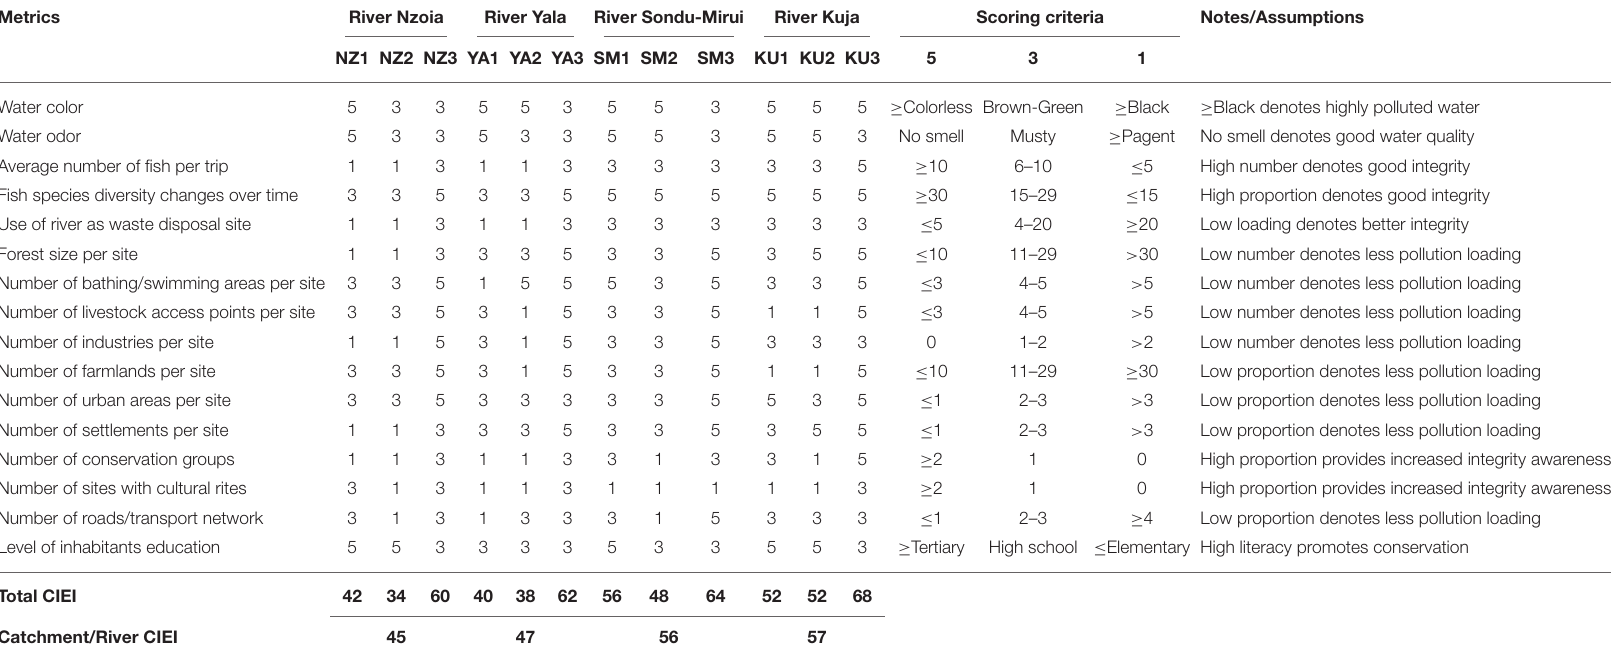
TABLE 2 | Developed Citizen Index of Ecological Integrity (CIEI) for ranking of major river catchments in relation to community perceptions on the pollution status in the lower reaches of Lake Victoria, Kenya.